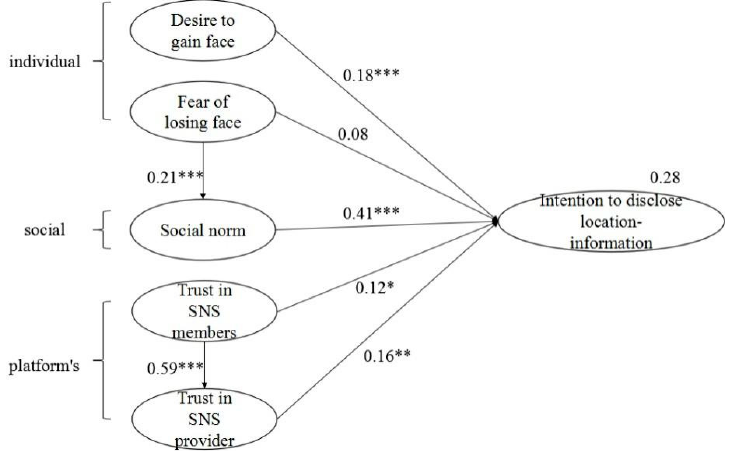
Figure 3. Path analysis results of Group1 & Group2.